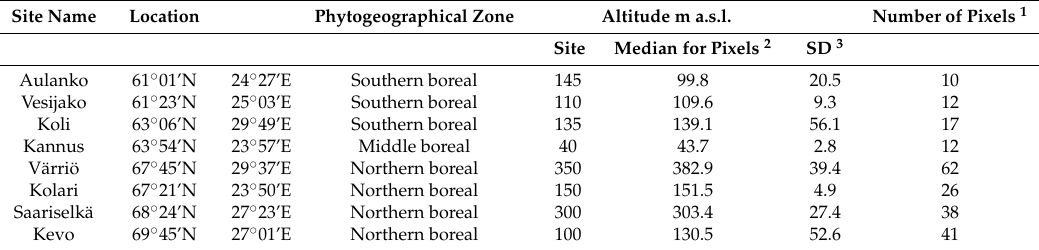
Table 1. Phenological observation sites for the evaluation of DBF_SOS sat and characteristics of MODIS pixels at 0.05 ˝ by 0.05 ˝ resolution that were used in the